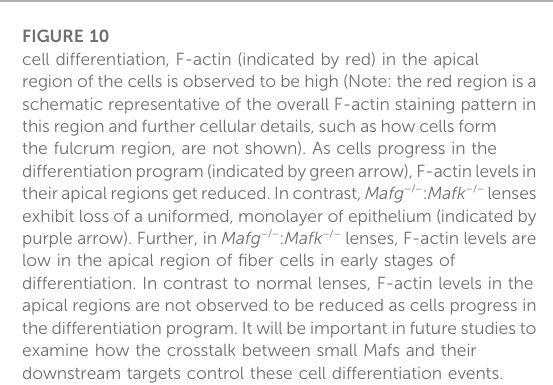
FIGURE 10 cell differentiation, F-actin (indicated by red) in the apical region of the cells is observed to be high (Note: the red region is a schematic representative of the overall F-actin staining pattern in this region and further cellular details, such as how cells form the fulcrum region, are not shown). As cells progress in the differentiationprogram(indicatedbygreenarrow),F-actinlevelsin theirapicalregionsgetreduced.Incontrast, Mafg − / − : Mafk − / − lenses exhibit loss of a uniformed, monolayer of epithelium (indicated by purple arrow). Further, in Mafg − / − : Mafk − / − lenses, F-actin levels are low in the apical region of fi ber cells in early stages of differentiation. In contrast to normal lenses, F-actin levels in the apical regions are not observed to be reduced as cells progress in the differentiation program. It will be important in future studies to examine how the crosstalk between small Mafs and their downstream targets control these cell differentiation